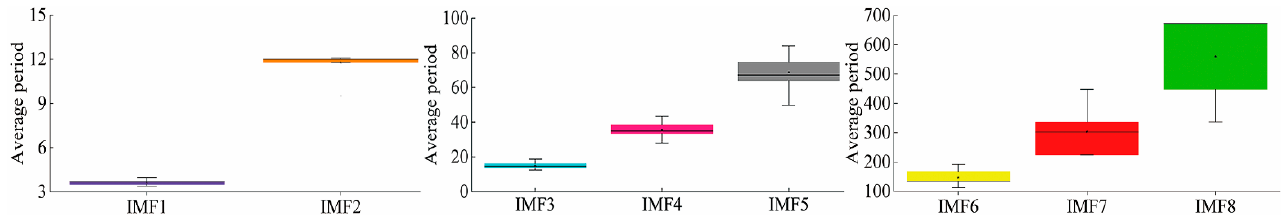
Figure 3. Boxplot of average periods of IMFs in the series of monthly precipitation in 18 meteorological stations.